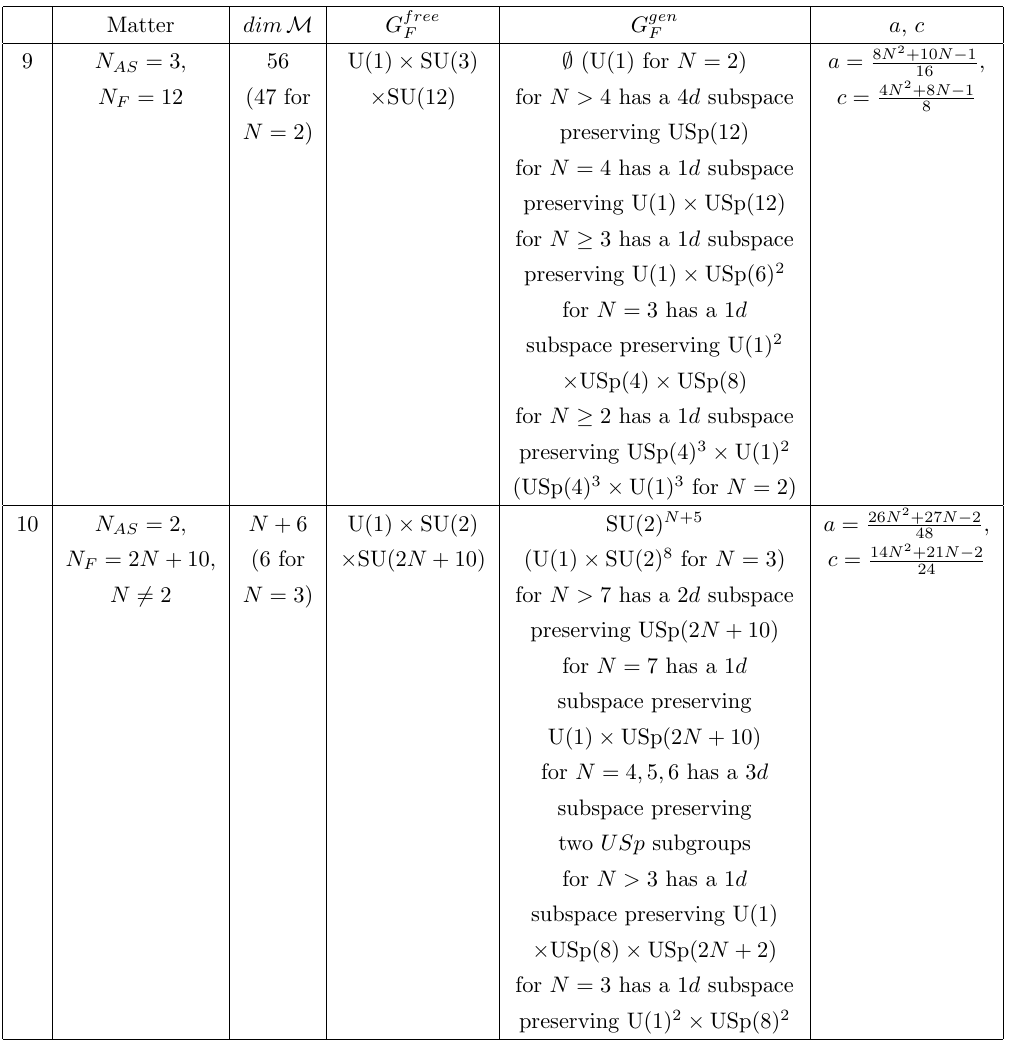
Table 13 . Cases involving a USp(2 N ) gauge group with only fundamental and antisymmetric chiral